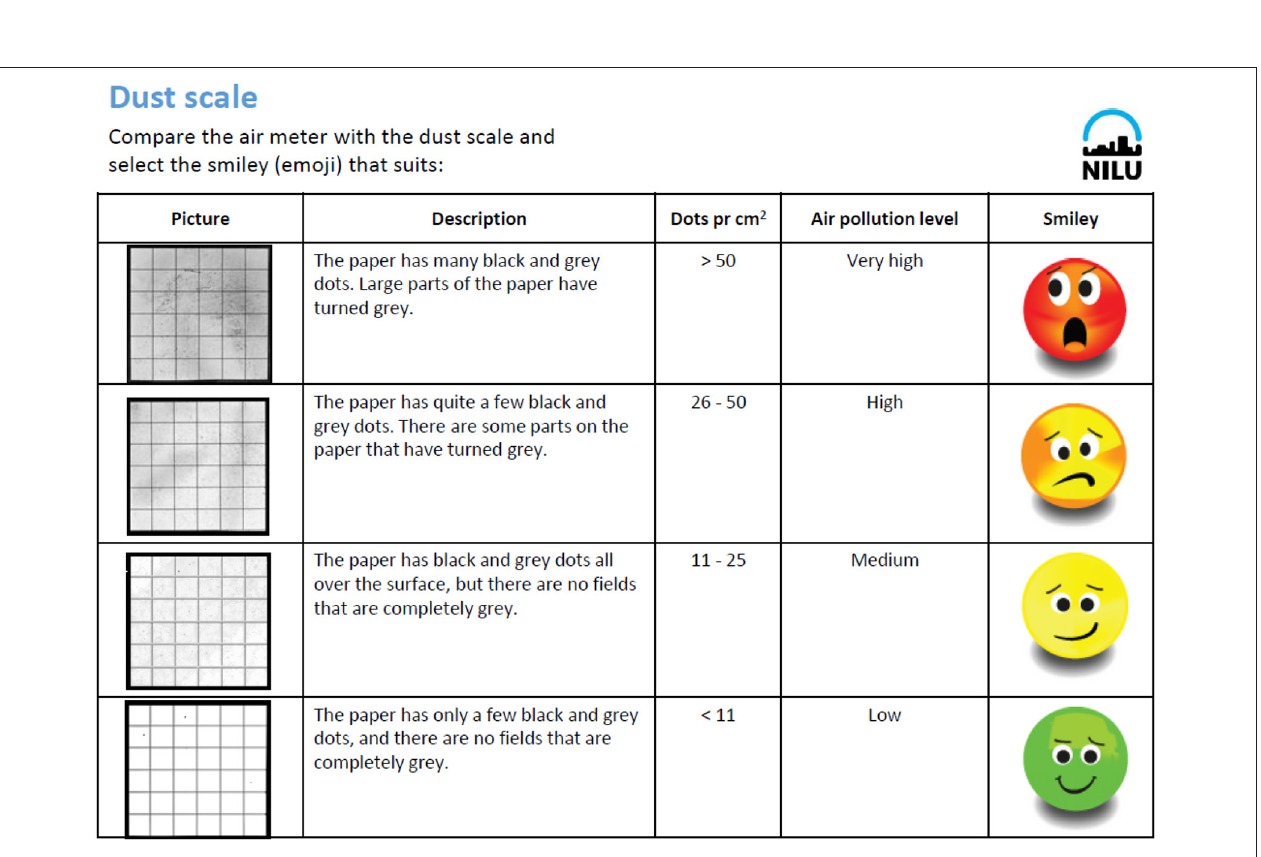
Frontiers in Climate |